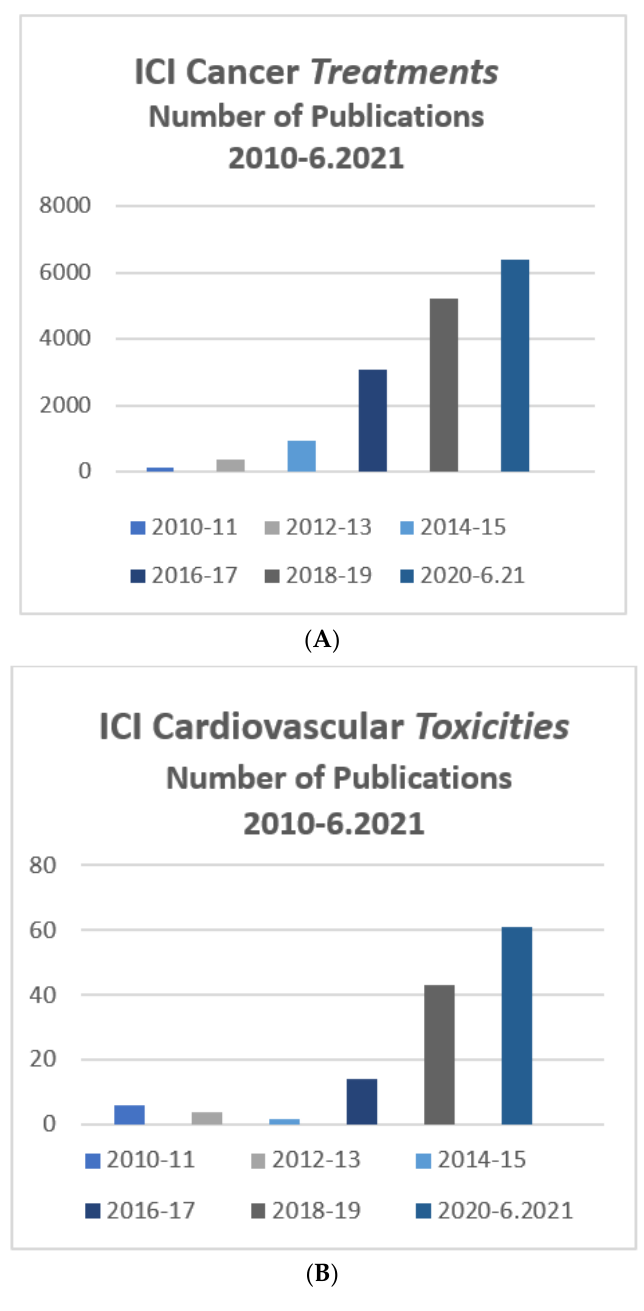
Figure 1. ( A ) Number of ICI treatment-related publications in recent years. ( B ) Number of ICI car- diovascular toxicities-related publications in recent